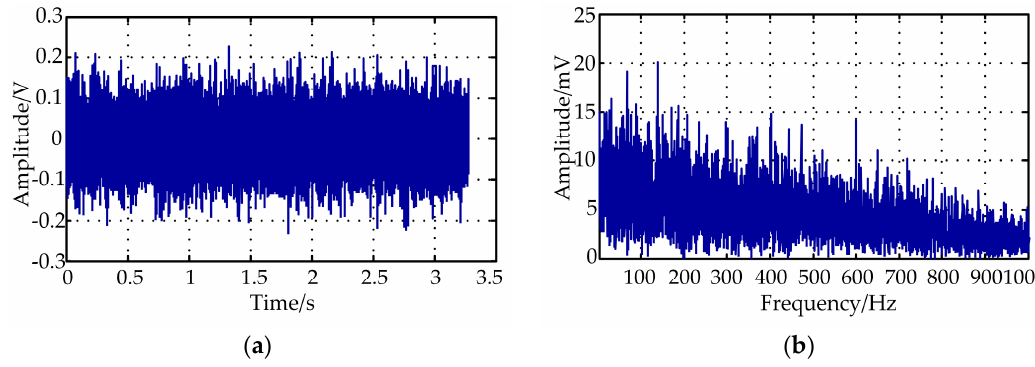
Figure 6. The waveform of the healthy bearing vibration signal. ( a ) Time domain waveform; ( b ) envelope spectrum waveform.